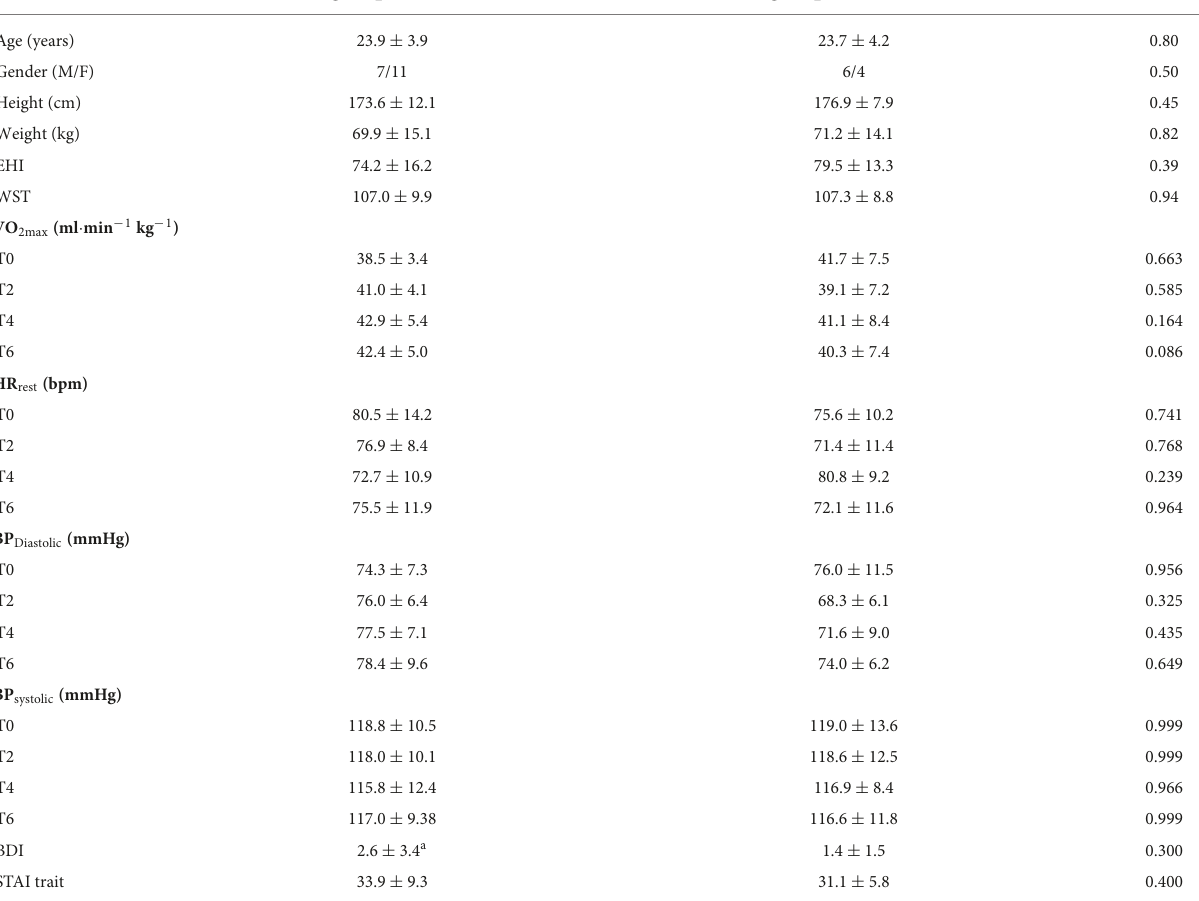
TABLE 1 Subject